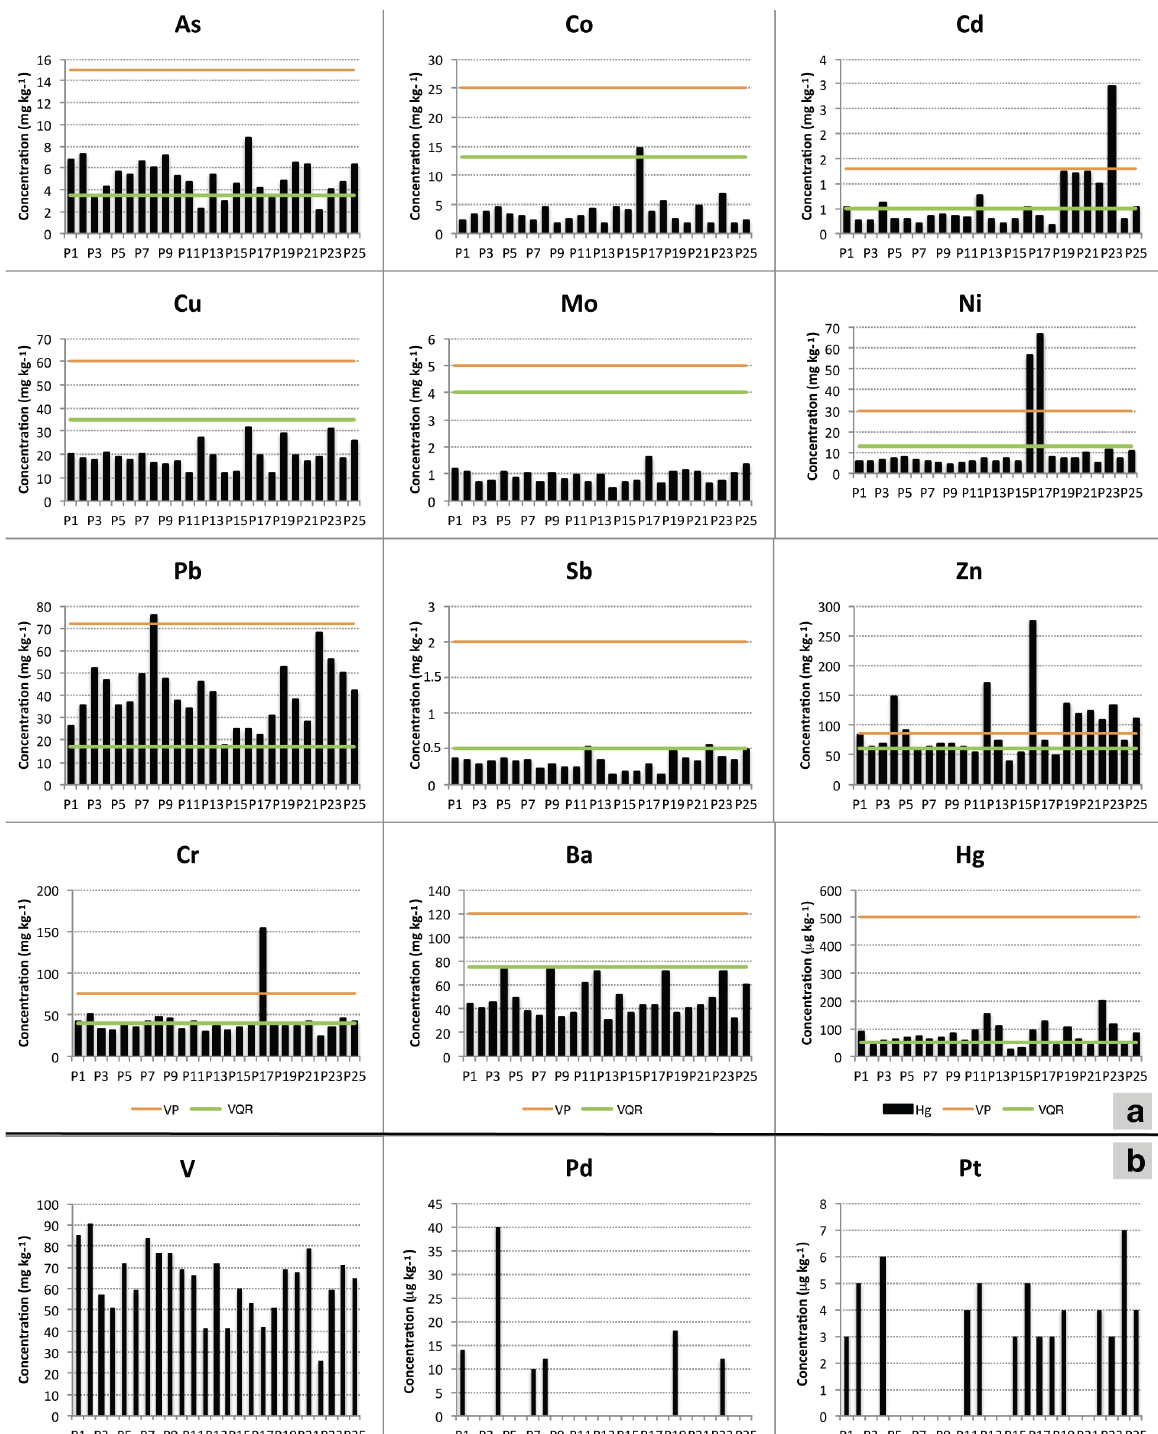
Figure 2 - a ) Variation of trace metals concentration (mg kg -1 ) in superficial soils and comparison with the Quality Reference (VQR) and Prevention values (VP) established by CETESB (2014). b ) Variation of vanadium concentration (mg kg -1 ), platinum and palladium concentration (µg kg -1 ) in topsoils (No Quality Reference Values or Prevention Values have been established by CETESB for these trace